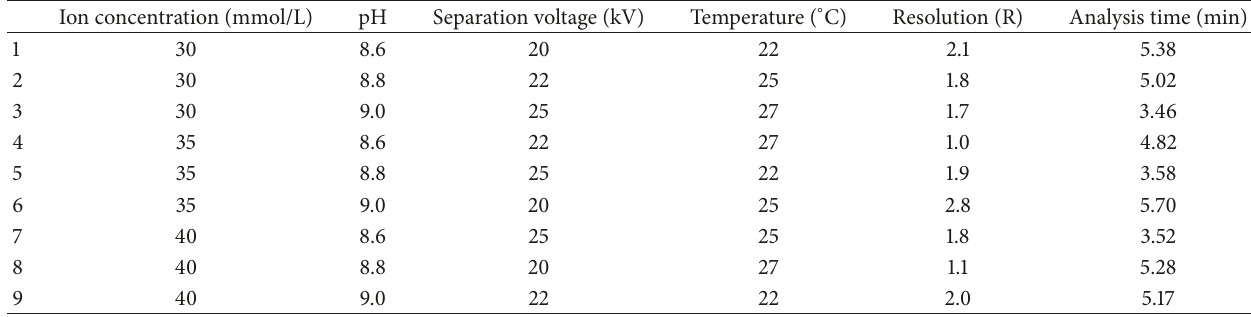
Table 1: The results of orthogonal experiment.